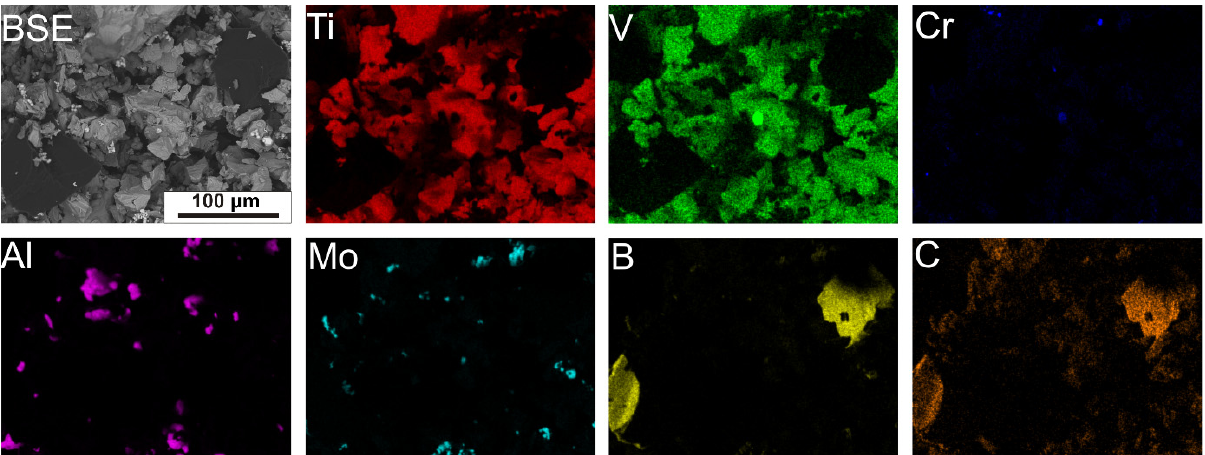
Figure 2. Alloying element distribution maps for a mixture of elemental powders obtained by EDS